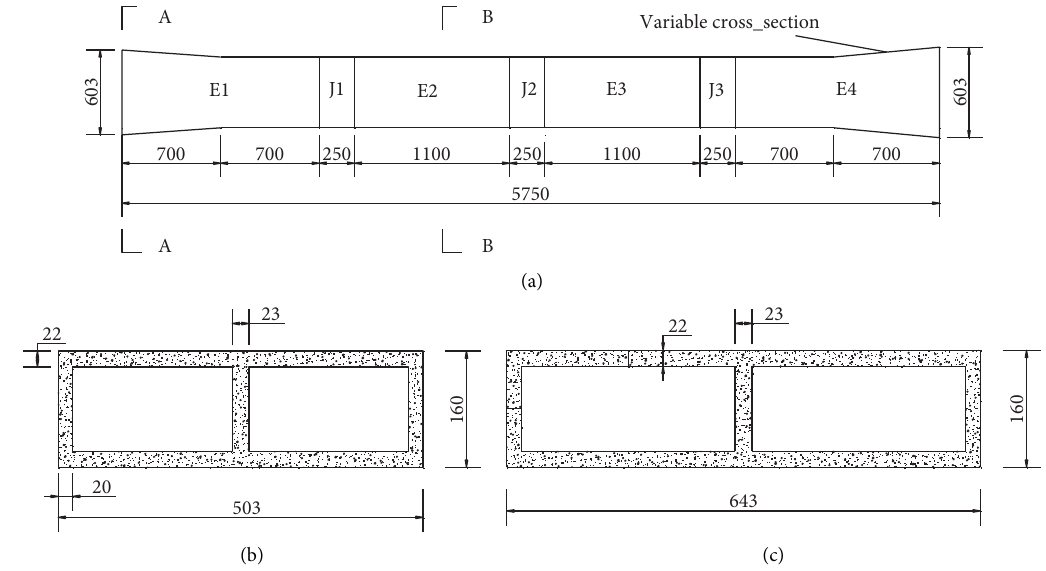
Figure 3: Immersed tunnel model (mm): (a) plane view; (b) sectional view of B-B; (c) sectional view of